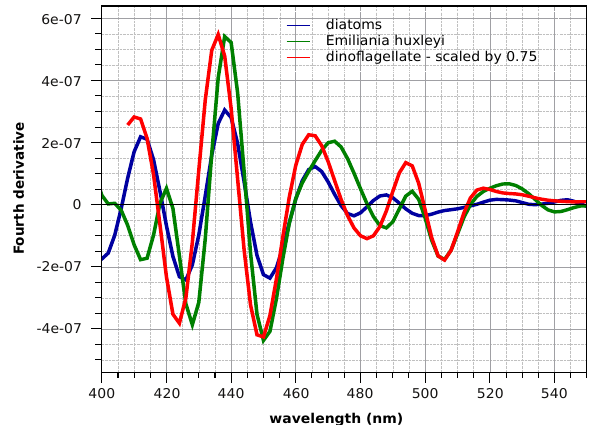
Fig. 4. The improvement to PhytoDOAS was performed by a simultaneous fit of the absorption spectra of selected phytoplankton targets in an appropriate wavelength window. This figure compares the overall residuals of the PhytoDOAS retrievals in three different fit-modes: without any PFT target (blue), only with the diatoms absorp-